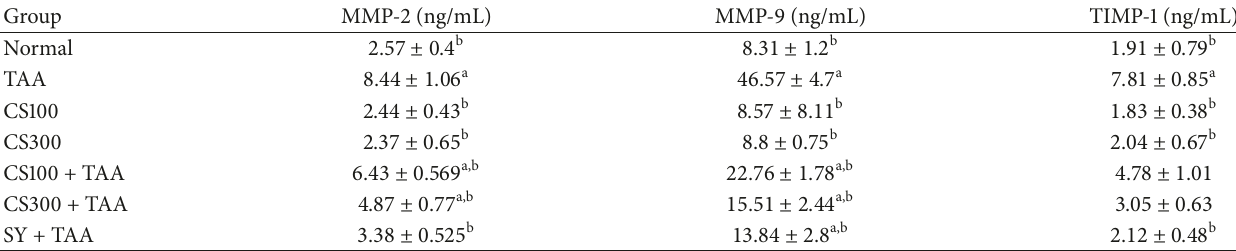
Table 4: Effects of CS extract treatment on the level of MMP-2, MMP-9, and TIMP-1 in the liver tissue at the end of 12